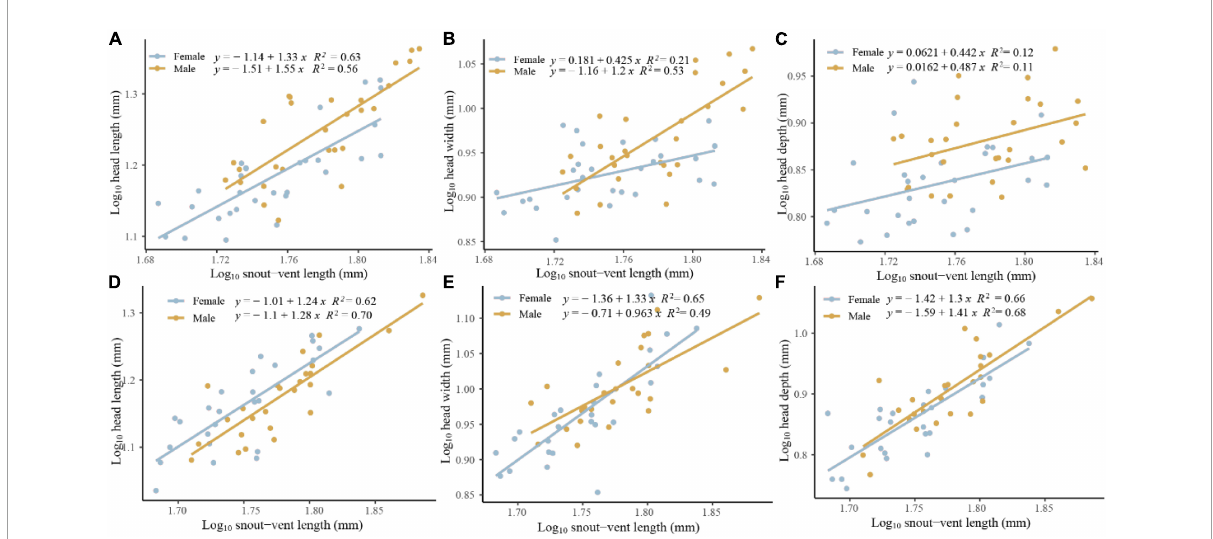
FIGURE3 Allometric pattern of head length (A,D) , width (B,E) , and depth (C,F) for Eremias grammica (A–C) and E. velox (D–F) males and females.